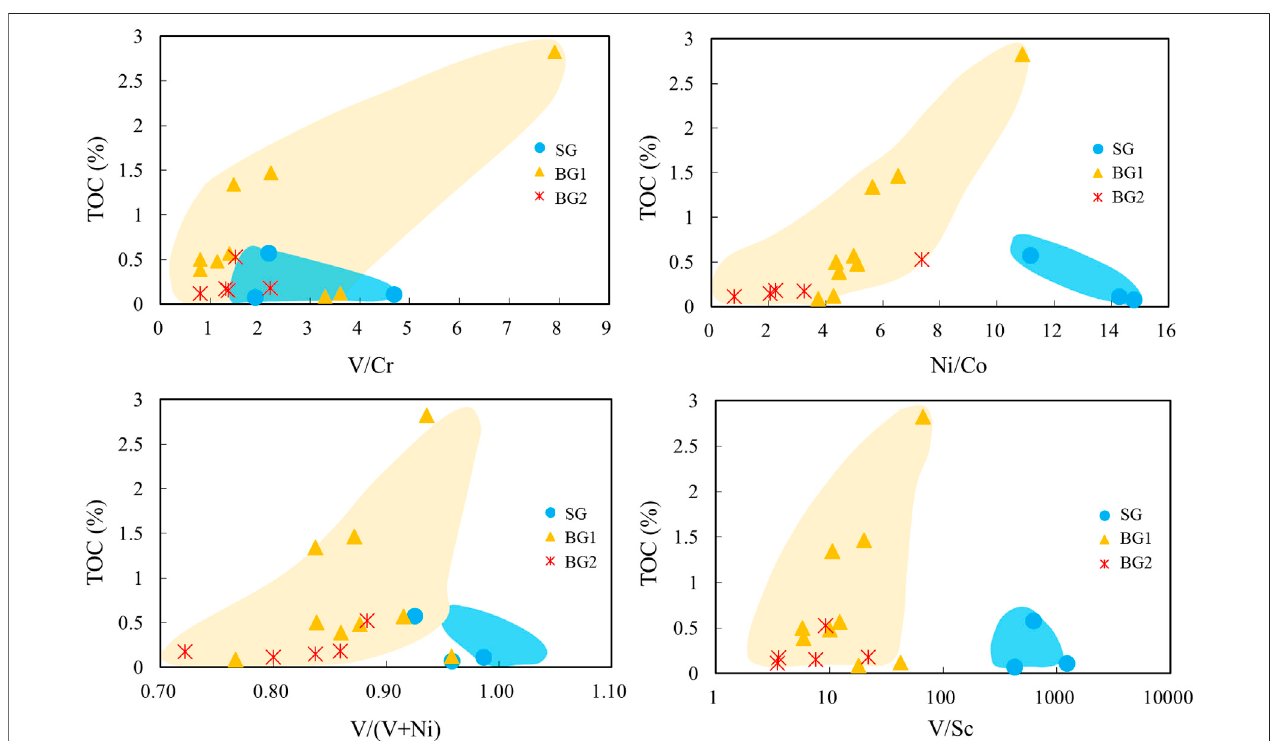
FIGURE 10 | Correlation between TOC and redox indexes of the Yuertusi Formation samples in the Yutixi outcrop.